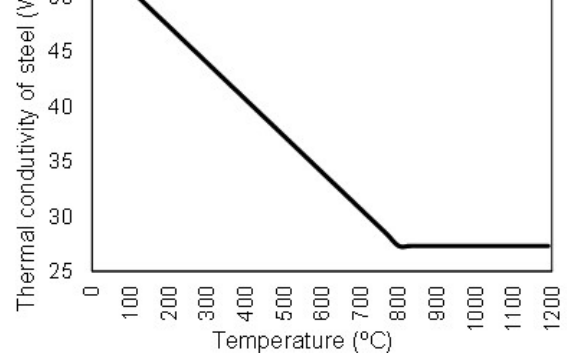
Figure A2 – Thermal conductivity of steel